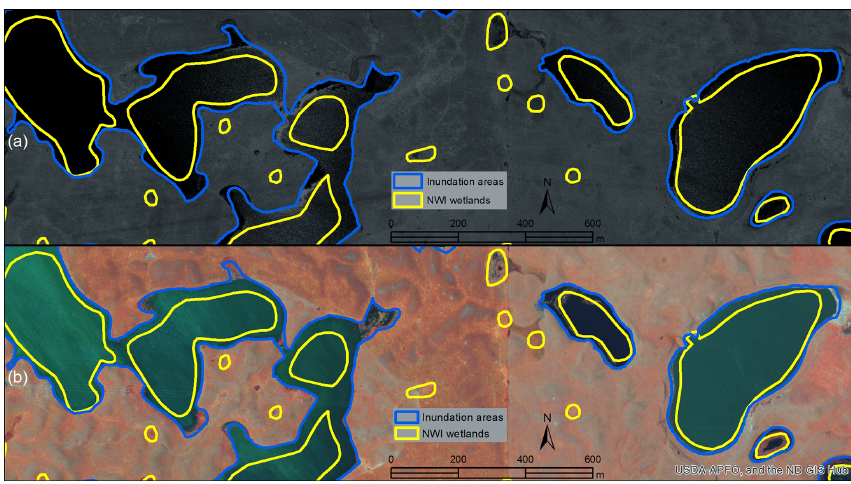
Figure 7. Comparison between inundation areas (derived from lidar intensity data) and NWI wetland polygons (image location: 47 ◦ 3 (cid:48) 34.474 (cid:48)(cid:48) N, 99 ◦ 9 (cid:48) 53.9 (cid:48)(cid:48) W). (a) Inundation areas and NWI wetlands overlaid on lidar intensity image; (b) inundation areas and NWI wetlands overlaid on color infrared aerial photograph